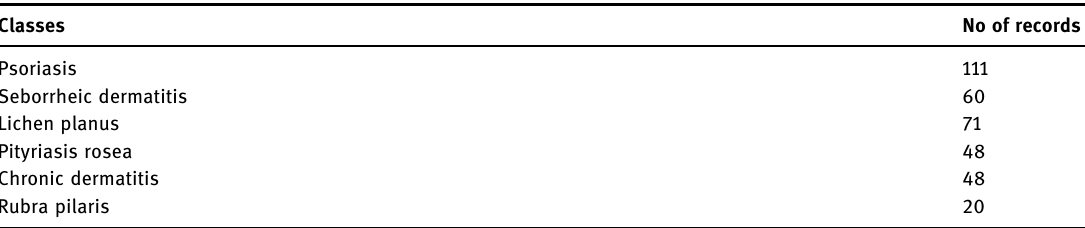
Table 1: Record distribution in the